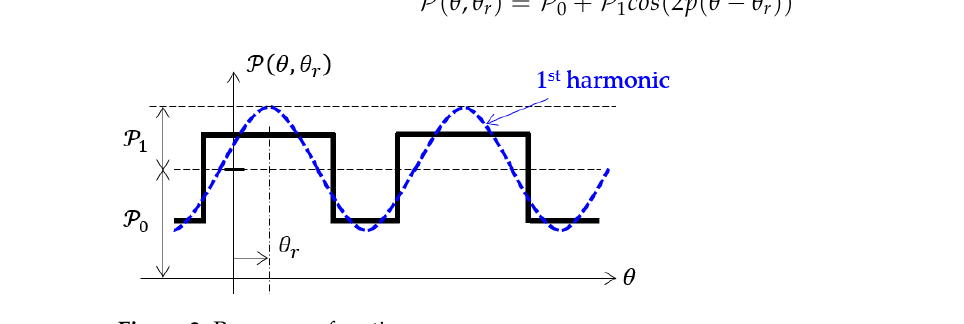
Figure 3. Permeance function.